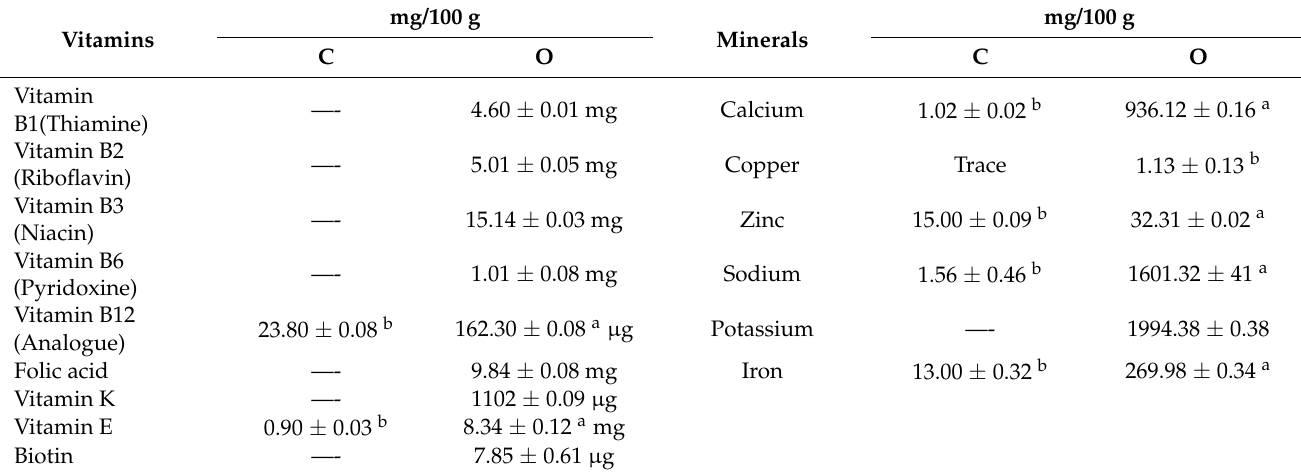
Table 7. Vitamins and minerals of the sample of control (C) and optimal snacks